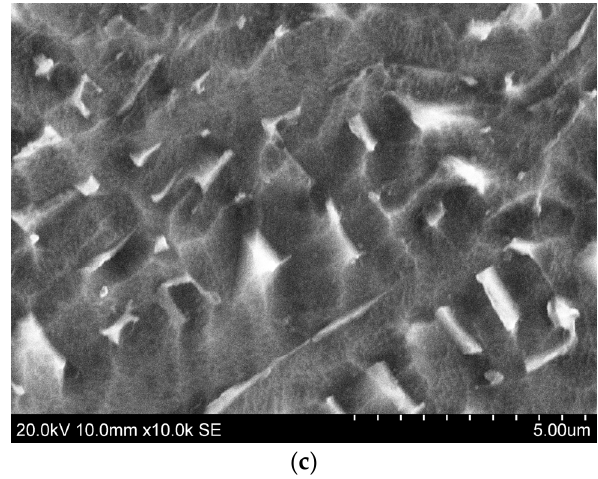
Figure 16. Microstructure of CMT deposition with forging after two-stage annealing: ( а ) ×1000; ( b ) ×3000; ( c ) ×10,000.